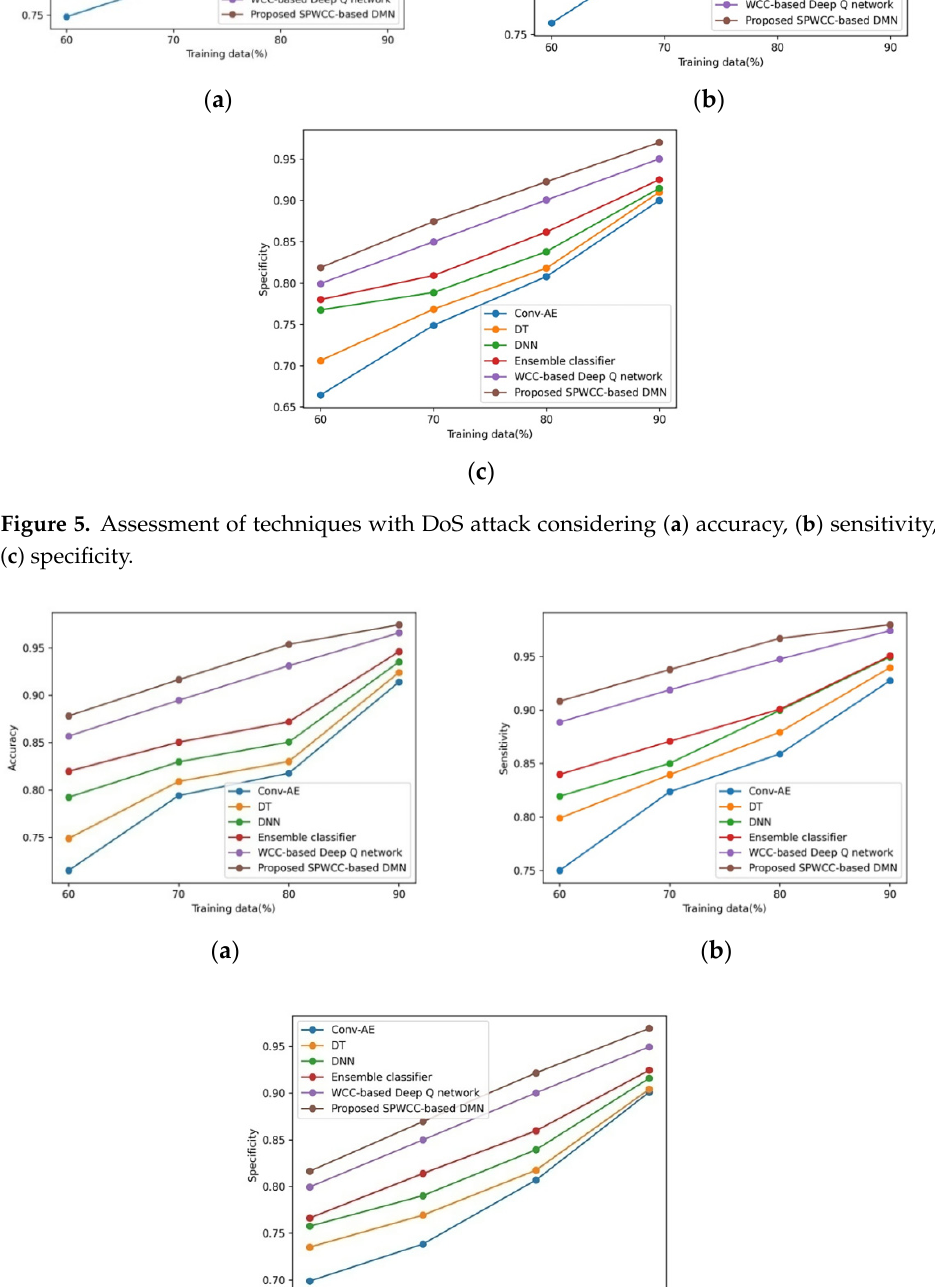
Figure 5. Assessment of techniques with DoS attack considering ( a ) accuracy, ( b ) sensitivity, and ( c ) specificity.